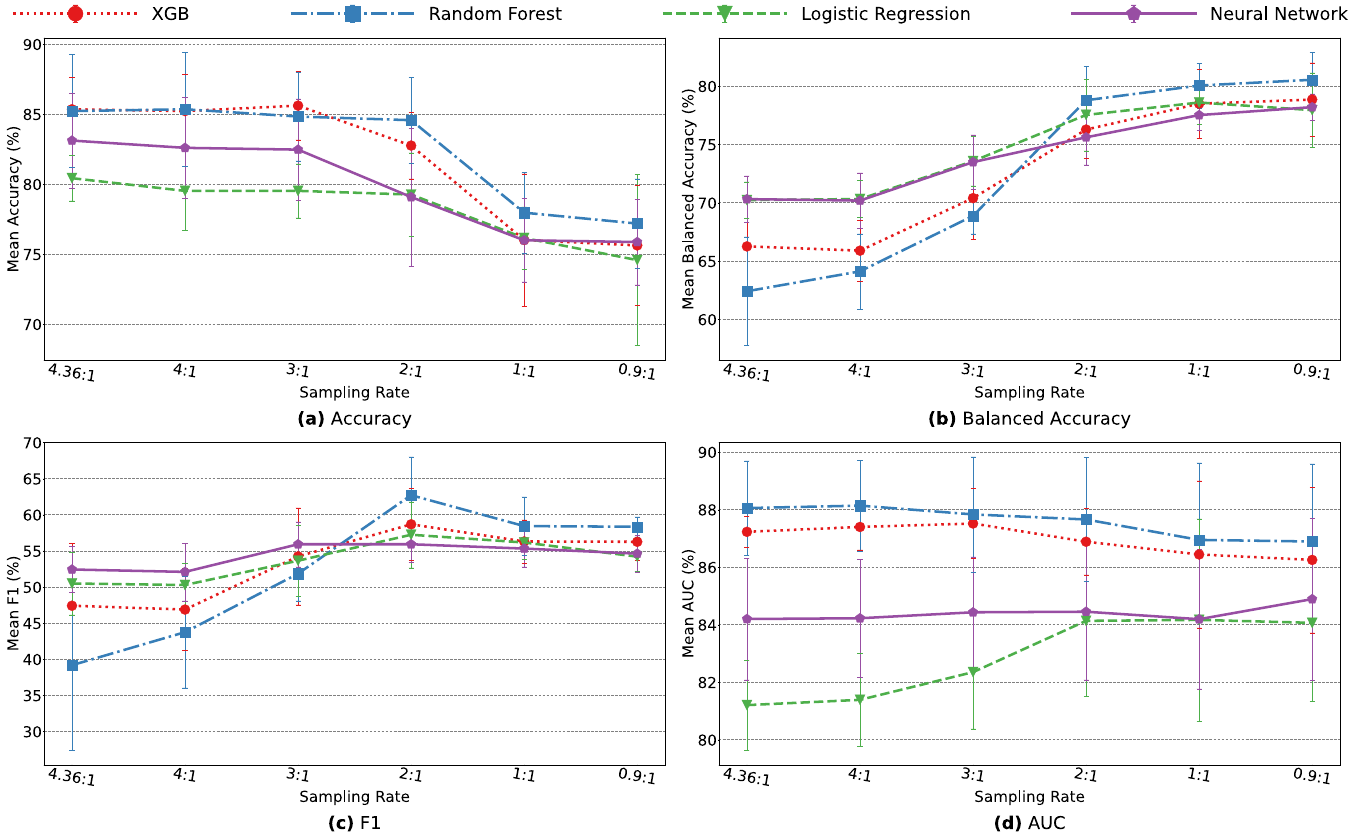
Fig 13. Mean accuracy, balanced accuracy, F1-score and AUC values comparisons using different sampling ratios. 4.36:1 indicates no random under sampling (original sample distributions between completion trials vs . cessation trials in the dataset).